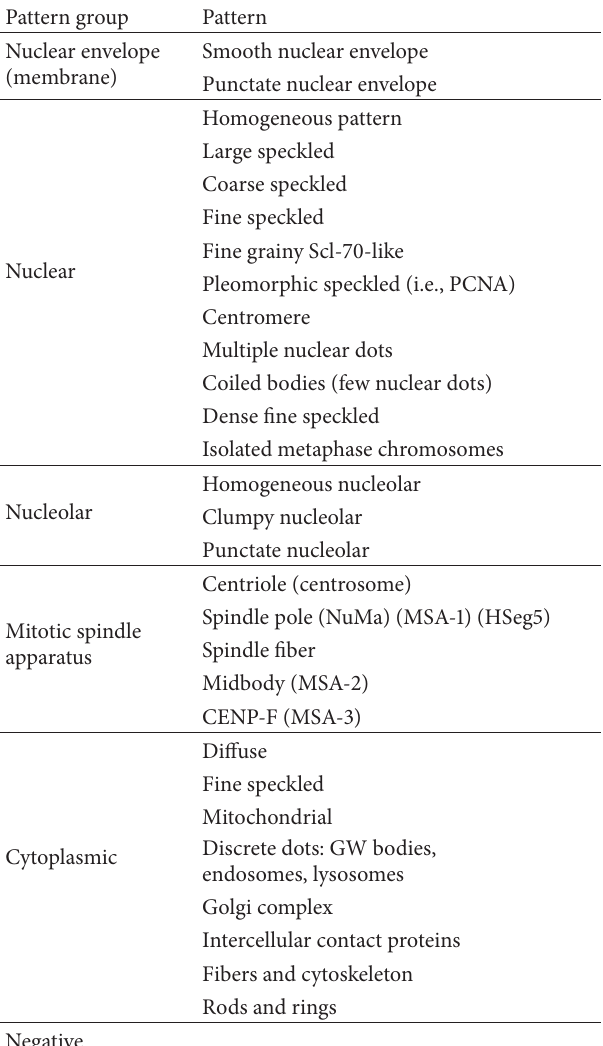
Table 6: Overview of defined ANA patterns (modified from Wiik et al., 2010